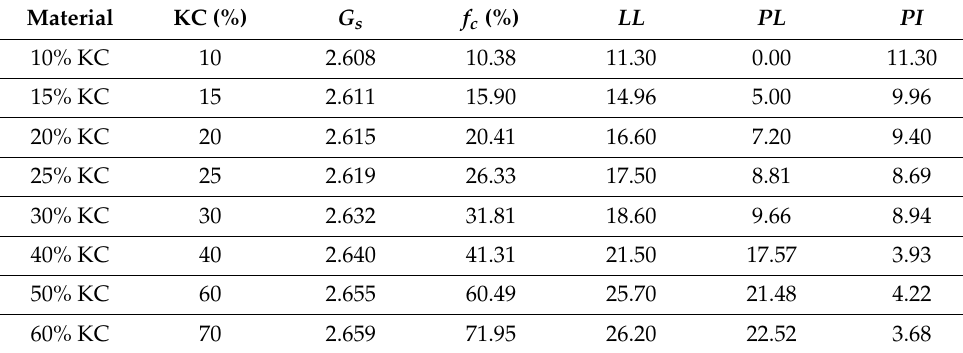
Table 1. Index properties of kaolinite–sand